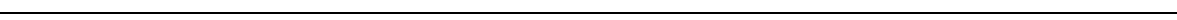
Fig. 5 Impact of Vps34 inactivation on cellular PI3P and autophagy. a – c Analysis of total PI3P levels by mass assay in different cell types/tissues. Mice were randomly fed or starved overnight. Hepatocytes were cultured overnight in insulin-free HM media. 5 mice/genotype were used for all tissues, except for primary hepatocytes (cell cultures derived from 4 individual mice/genotype). Data represent mean ± SEM (non-parametric Mann – Whitney t -test). d Left panel, representative images of confocal analysis of endogenous PI3P pools in primary hepatocytes. Cells were cultured overnight in insulin-free HM, digitonin-permeabilized and co-stained using a GST-2xFYVE HRS probe (red) or EEA1 antibody (green). DAPI-stained nuclei are shown in blue. Cell cultures derived from 3 – 5 independent mice/genotype were used. Scale bar, 20 µ m. Right panel, quanti fi cation of FYVE and EEA1 puncta number from confocal images using Metamorph software. Cell cultures derived from 3 – 5 independent mice/genotype were used. Data represent mean ± SEM (Student t -test). e Left panel, representative images of confocal analysis of WIPI-2 puncta (red) of primary hepatocytes upon starvation (EBSS). Representative data from three independent experiments. DAPI-stained nuclei are shown in blue. HM: Hepatocyte medium + insulin. Scale bar, 20 µ m. Right panel, Quanti fi cation of WIPI-2 puncta in primary hepatocytes from confocal images using Metamorph software. HM: Hepatocyte medium (with insulin). Hepatocyte cultures derived from 3 – 5 independent mice/genotype were used. Data represent mean ± SEM (Student t -test). f Quanti fi cation of the LC3 lipidation assay in primary hepatocytes shown in Supplementary Fig. 4b. Cells were freshly isolated from liver and were grown overnight in HM. For autophagy induction, cells were incubated in EBSS in absence or presence of 100 nM Ba fi lomycin A1 (BafA1) for the indicated times. Cell lysates were immunoblotted with the indicated antibodies. Representative data from three independent experiments are shown. Data represent mean ± SEM (Student t -test). g Quanti fi cation of p62 levels in liver tissues shown in Supplementary Fig. 4c. Fresh livers were snap-frozen and lysed before performing immunoblotting with the indicated antibodies. n = 4 mice/genotype. Data represent mean ± SEM (non-parametric Mann – Whitney t -test) * p < 0.05, ** p ≤ 0.01, *** p ≤